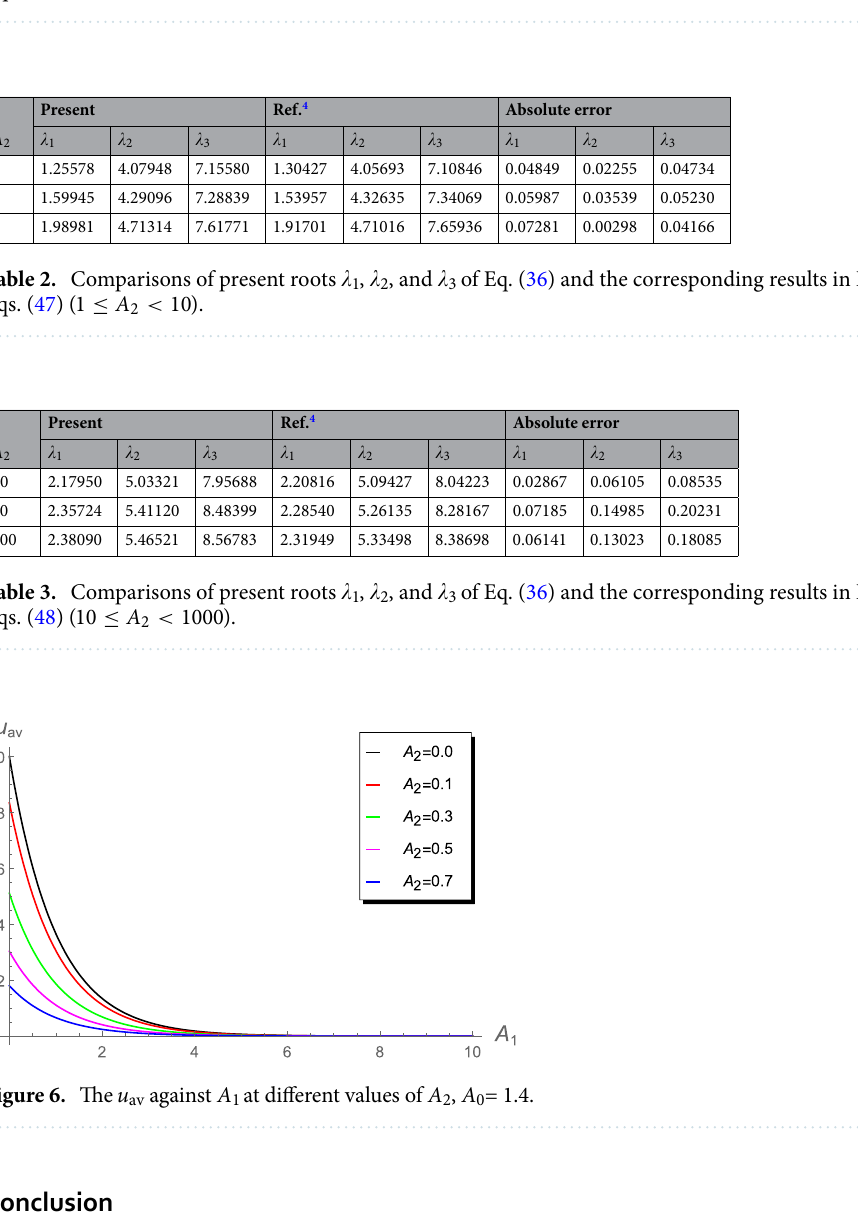
Table 1. Comparisons of present roots (cid:31) 1 , (cid:31) 2 , and (cid:31) 3 of Eq. (36) and the corresponding results in Ref. 4 using A Eqs. (46) ( 0.01 2 < 1 ). ≤